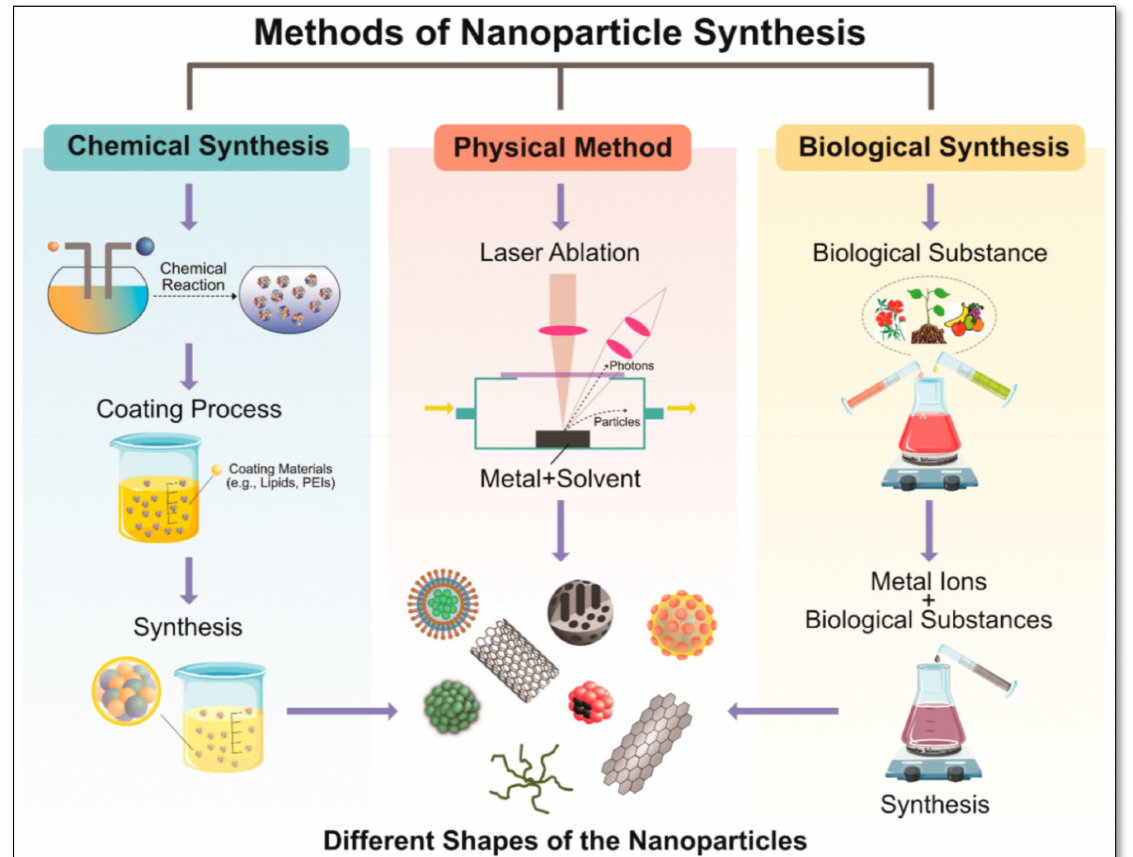
Figure 1. Method of nanoparticles synthesis